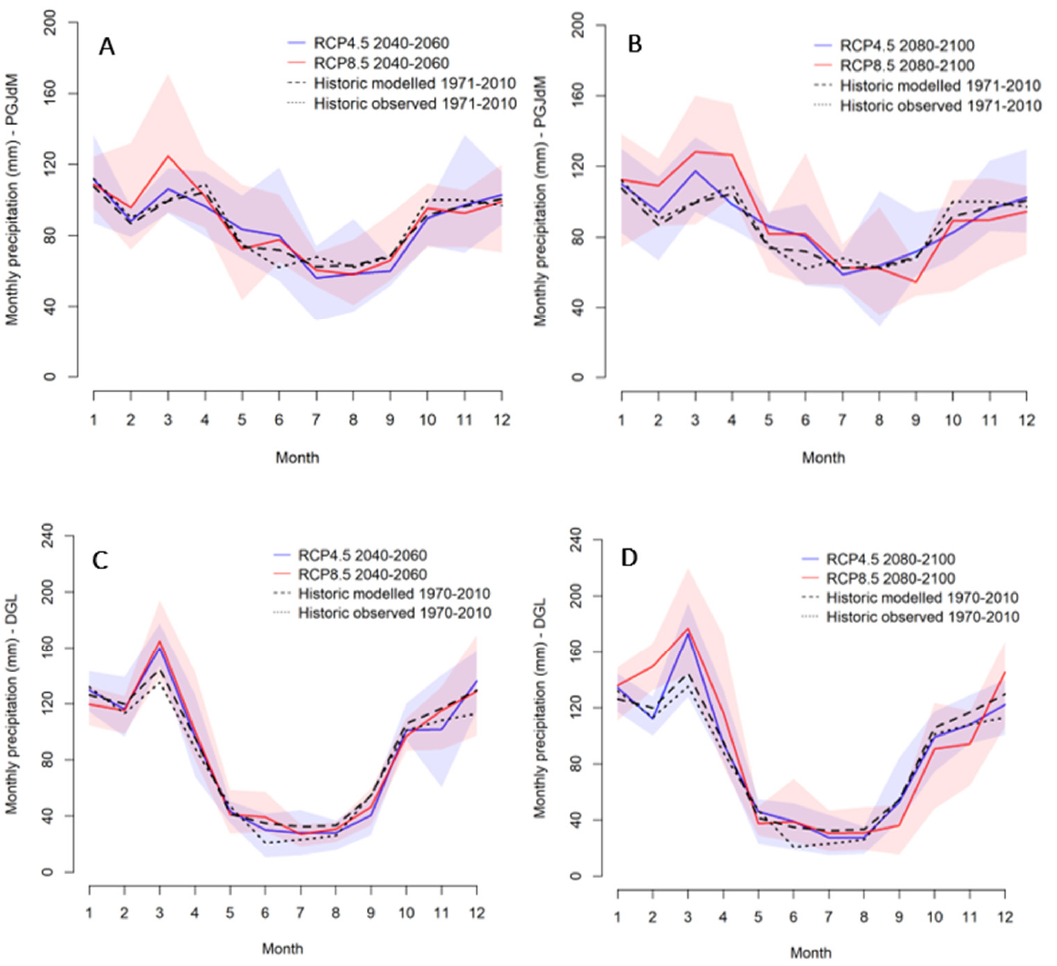
Figure 3. Monthly precipitation change (mm) in the PGJdM in 2040–2060 ( A ) and 2080–2100 ( B ) and monthly precipitation change (mm) in the DGL in 2040–2060 ( C ) and 2080–2100 ( D ) compared to modelled historic precipitation (1971–2010). The future precipitation figures are based on the RCP4.5 (blue) and RCP8.5 (red) scenarios, with respective solid lines representing the ensemble average (mean of means per month) and the transparent field representing the ensemble extremes (most extreme mean).